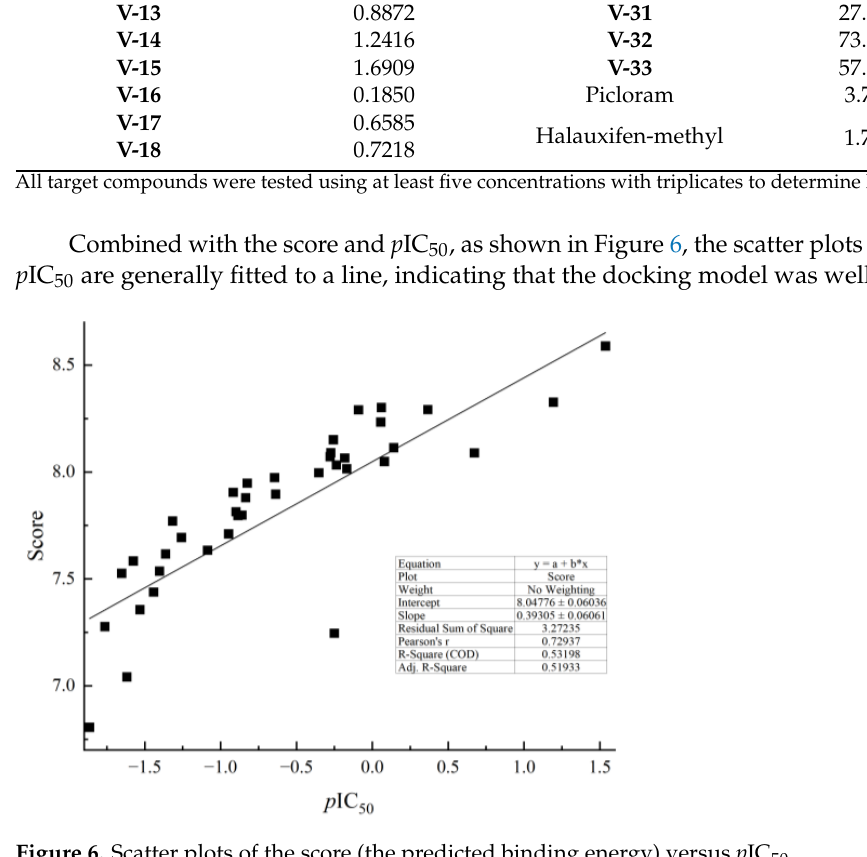
Figure 6. Scatter plots of the score (the predicted binding energy) versus p IC 50 .